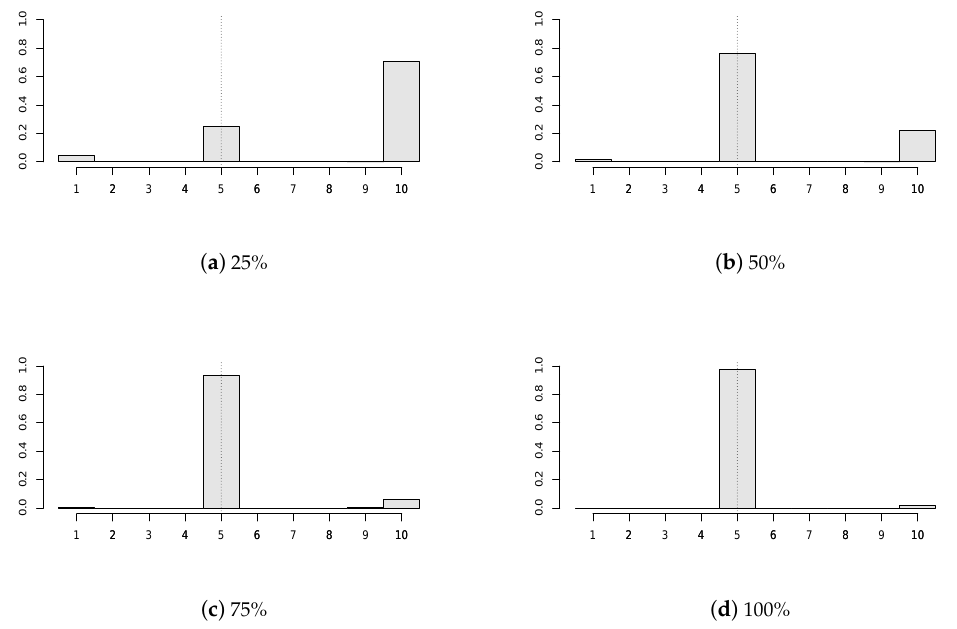
Figure 5. Histograms of the estimated change points (cid:98) τ N when various portion of the panels are subject to a break of size δ i ∼ U [ 0,2 ] ( τ = 5, T = 10, N = 20, σ = 0.2, panel disturbances from GARCH(1,1) with t 5